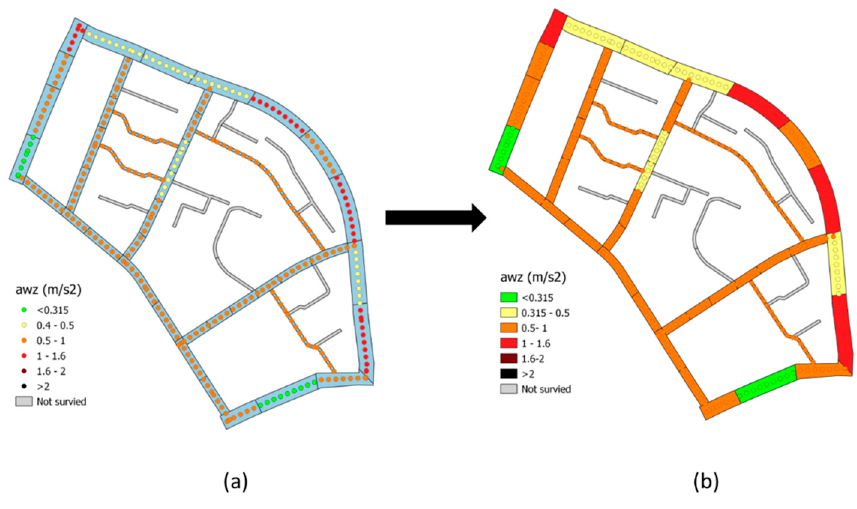
Figure 9. Visualization of a wz results in GIS: ( a ) point representation ( b ) sample unit